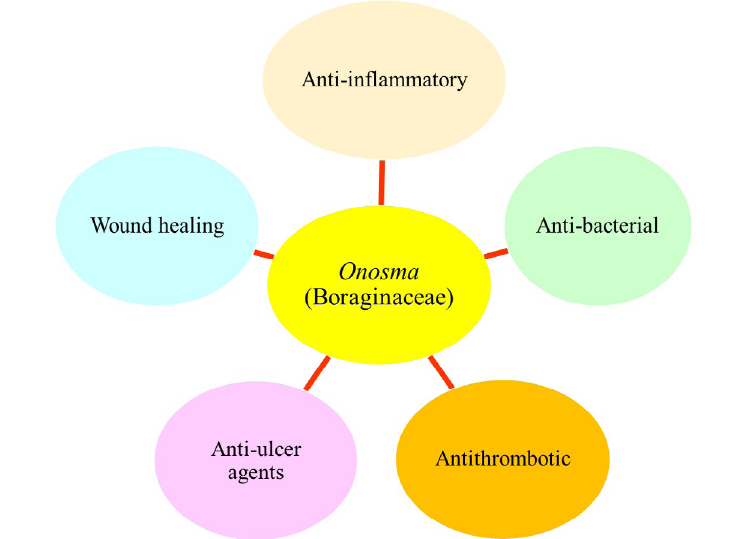
Figure 2. Different medicinal properties of the O . genus